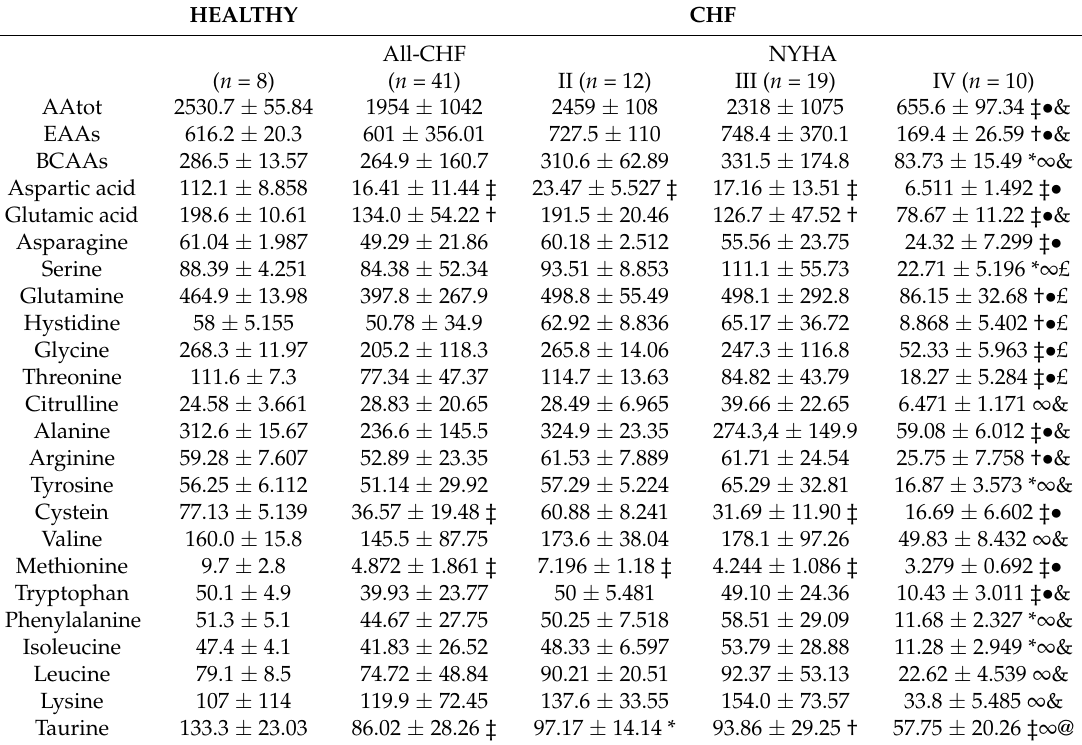
Table 2. Arterial concentrations of amino acids ( µ mol L − 1 ) in healthy subjects and in CHF patients before and after NYHA categorization.